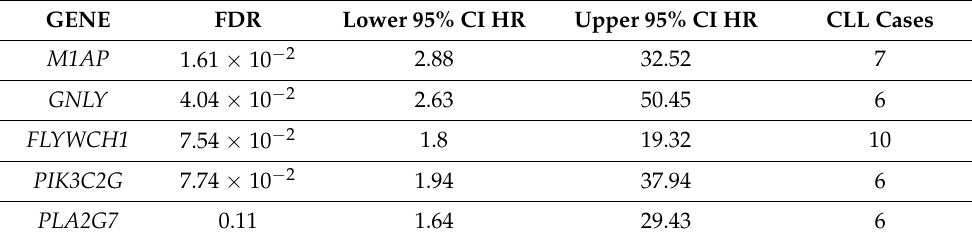
Table 6. Association results of high-impact variants with overall survival in CLL.